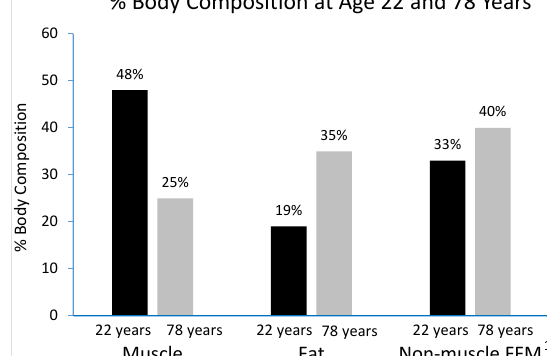
Figure 1. Changes in the relative weights of the different compartments of body composition with ageing. Values are expressed as percentage of total body mass, adapted from Short et al. , 2000 [12]. 1 Fat-free mass